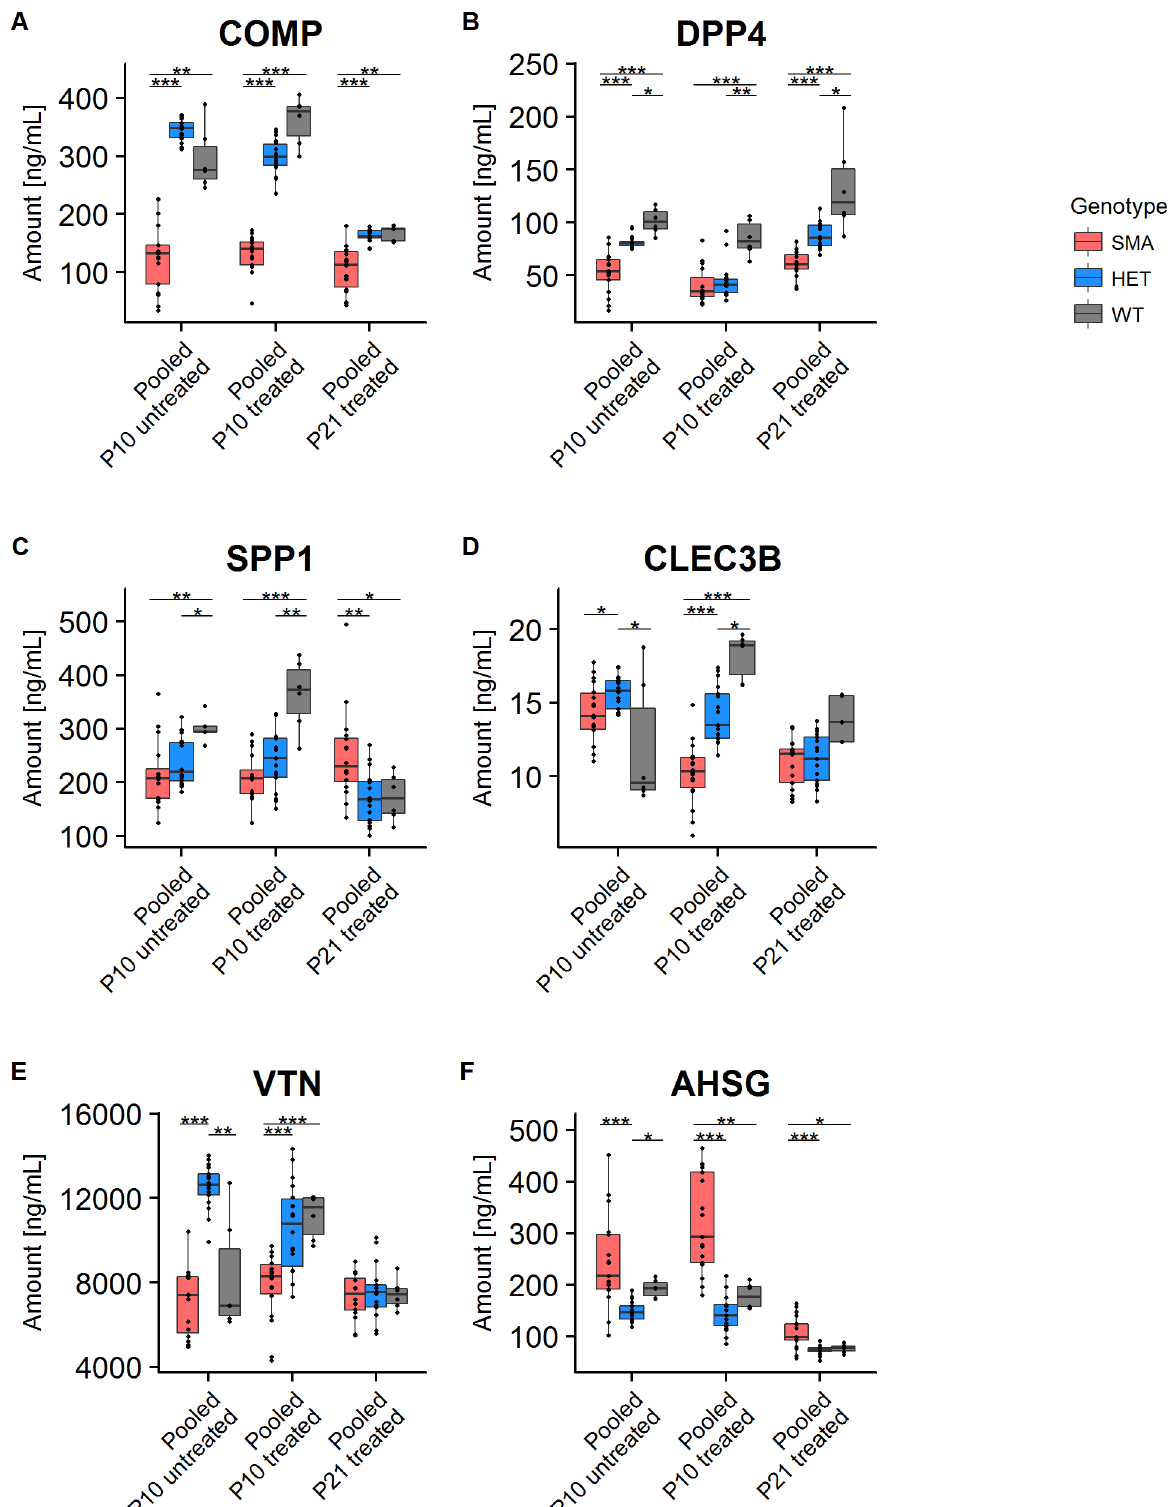
Fig 4. Protein plasma concentrations of six putative biomarkers in pooled groups. Multiple comparisons of unteated and ASO-treated pooled SMA and HET groups at P10 and P21 showing (A) COMP, (B) DPP4, (C) SPP1, (D) CLEC3B, (E) VTN and (F) AHSG concentrations in comparison to WT and WT+ASO, respectively (see also S5 and S6 Tables). (Dunn tests, Holm-corrected for multiple comparisons). Only comparisons leading to a significant difference are shown ( (cid:3) P (cid:20) 0.05; (cid:3)(cid:3) P (cid:20) 0.01, (cid:3)(cid:3)(cid:3) P (cid:20) 0.001).